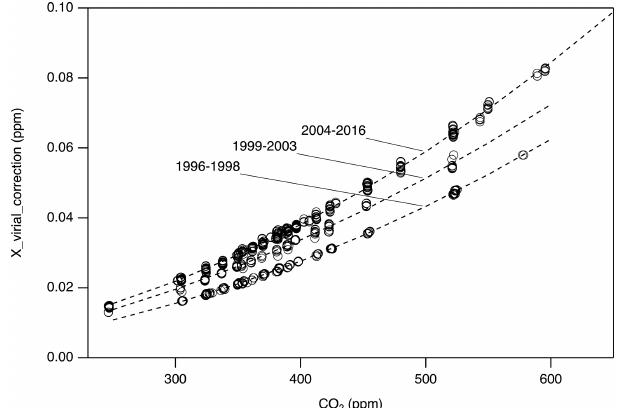
Figure 4. Corrections applied to account for an incorrect second virial coefficient ( X virial_correction ). Three second-order polynomial functions were used corresponding to periods with nominally dif- ferent volume ratios. Measurements performed after 2016 do not require this correction.